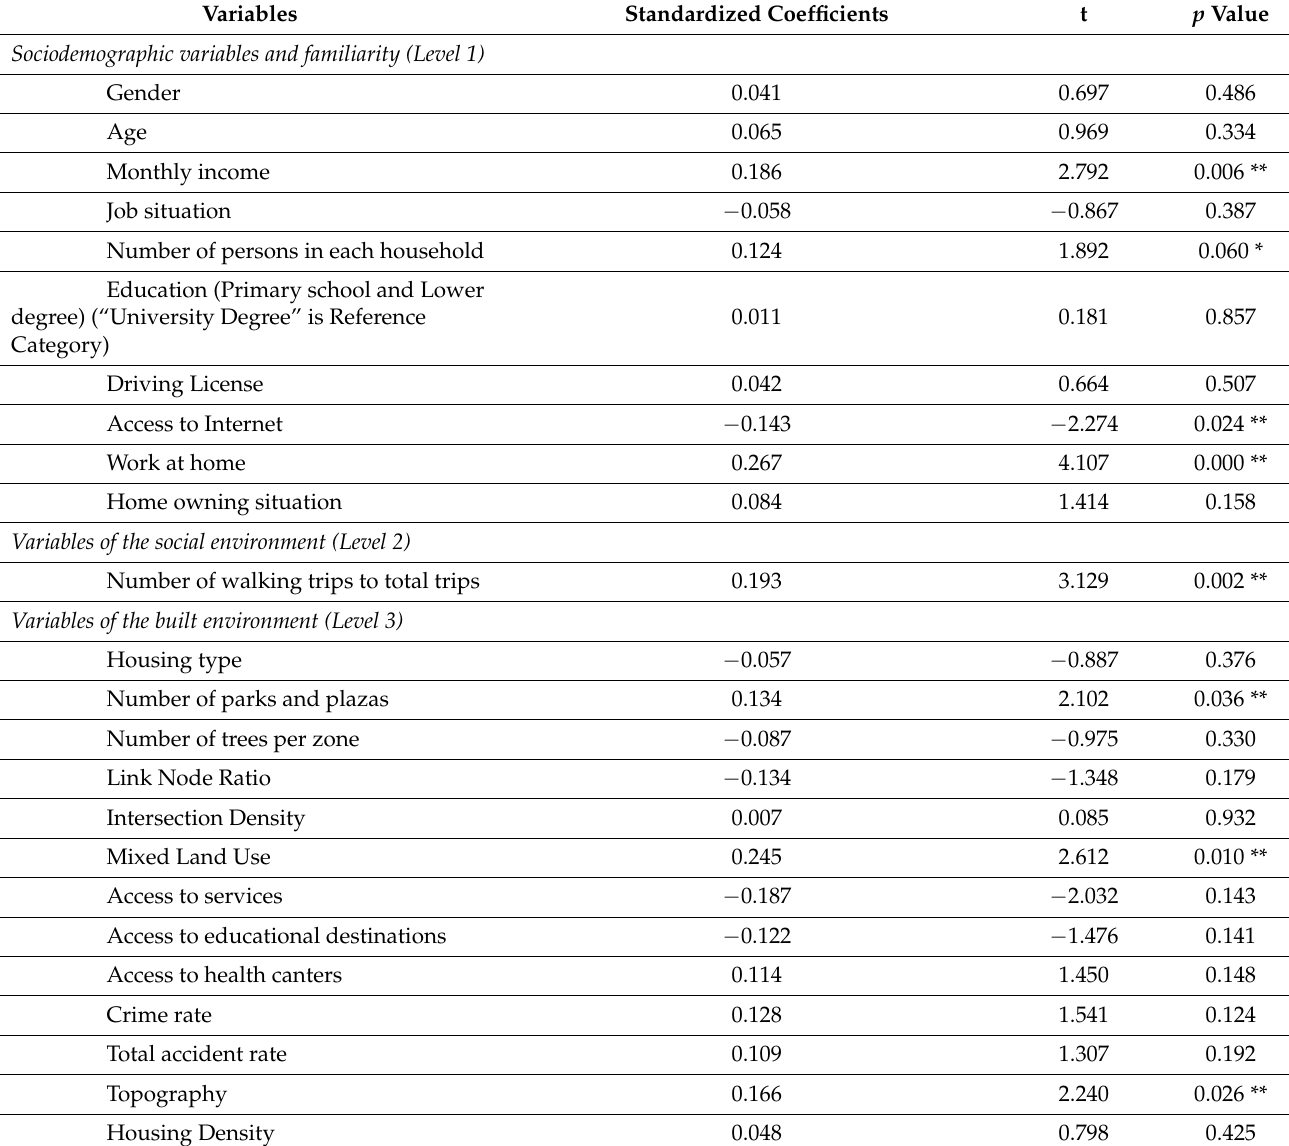
Table 6. The results of hierarchical multiple regression analysis for predicting walking for shopping (N =